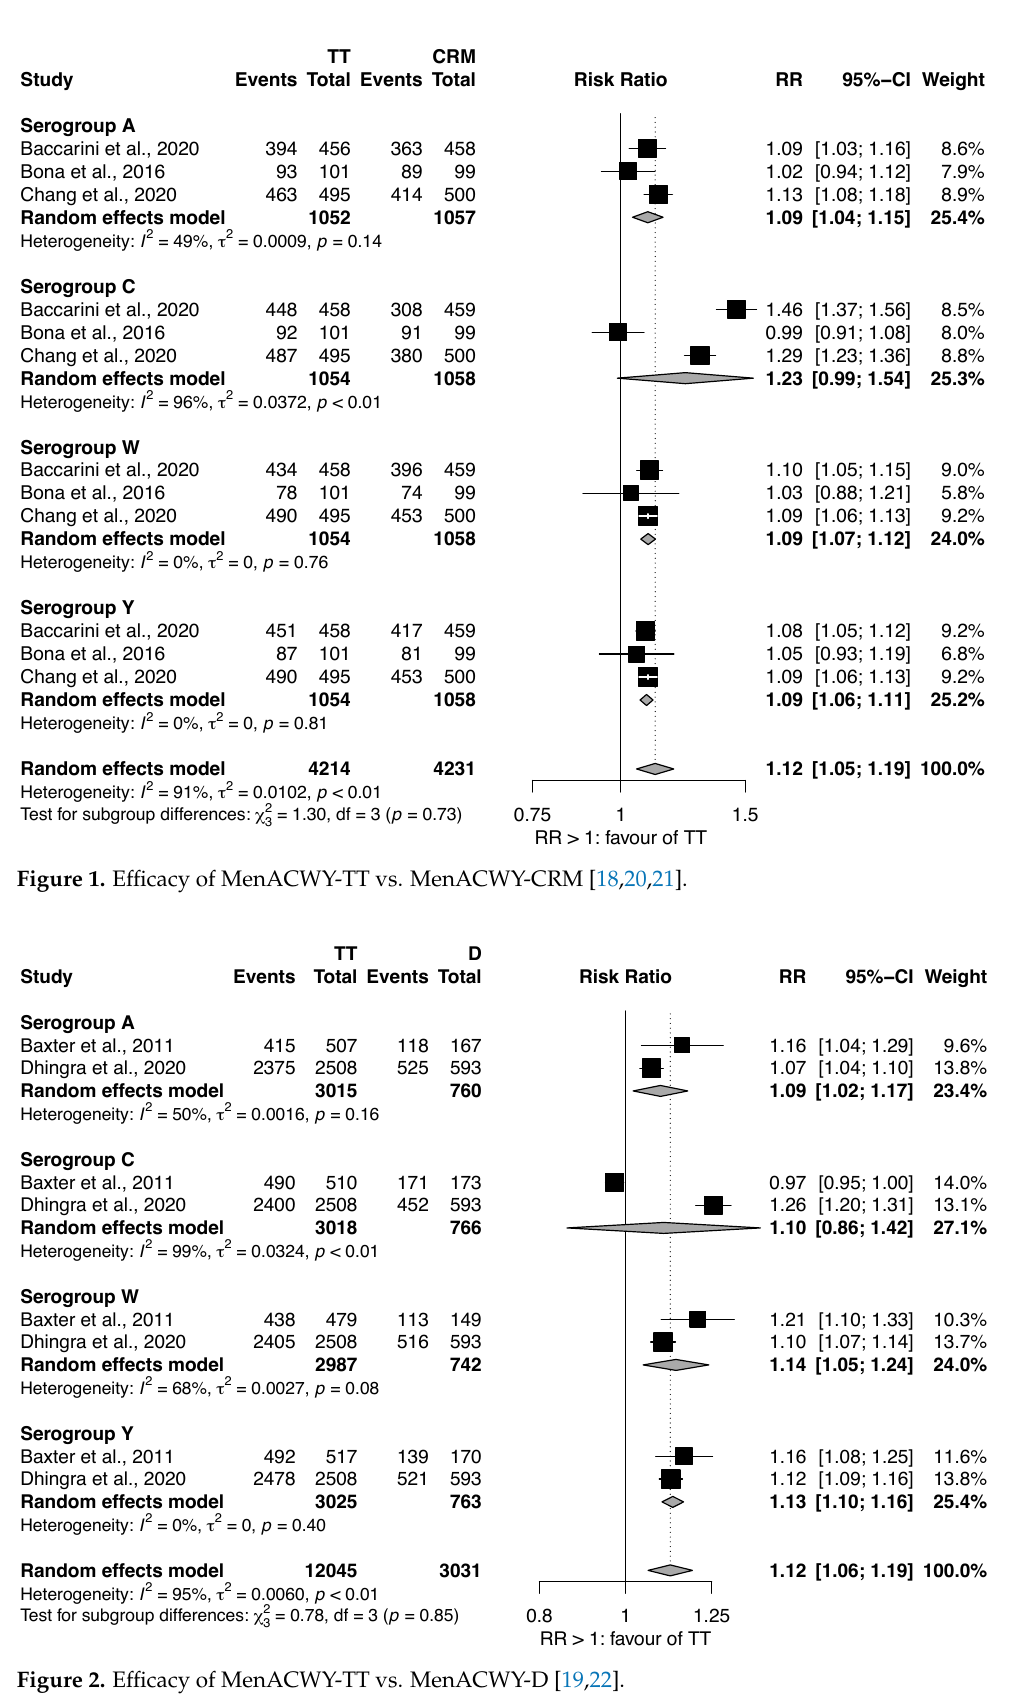
Figure 2. Efficacy of MenACWY-TT vs. MenACWY-D